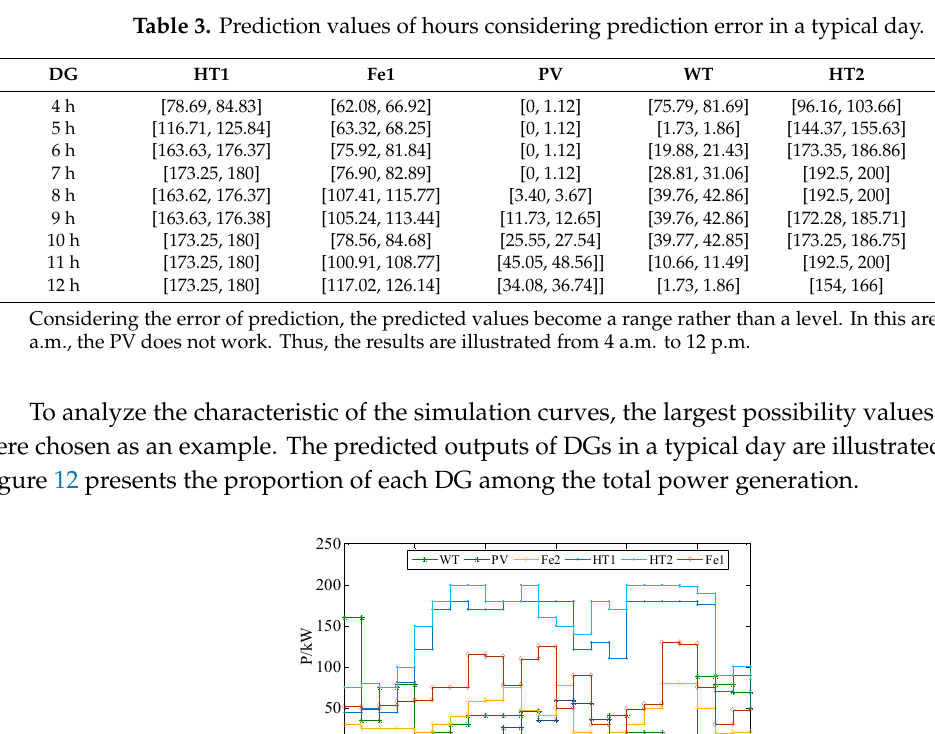
Figure 12. Total power generation and load. Basing on the predicted outputs of each DG, the optimal power output can be gained by redistribution through the method proposed in Section 3.2. The results are shown in Figures 13 and 14. As shown in Figure 13, when the prediction error is considered, the optimization results are turned to be a range of interval estimation, which is used to provide advice for day-ahead scheduling policies. ( f ) Figure 13. The optimal output of HD1 ( a ), The optimal output of FT1 ( b ), The optimal output of PV ( c ), The optimal output of WT ( d ), The optimal output of HD2 ( e ), The optimal output of FT2 ( f ).